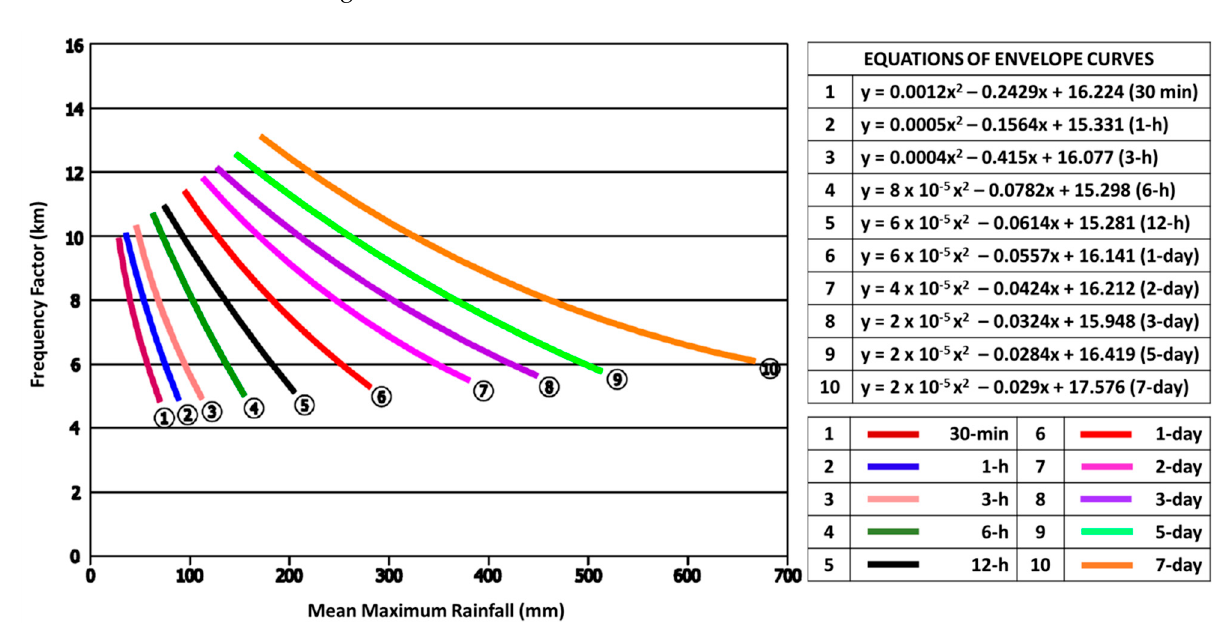
Figure 3. The Km envelope curve (West Malaysia) [14].